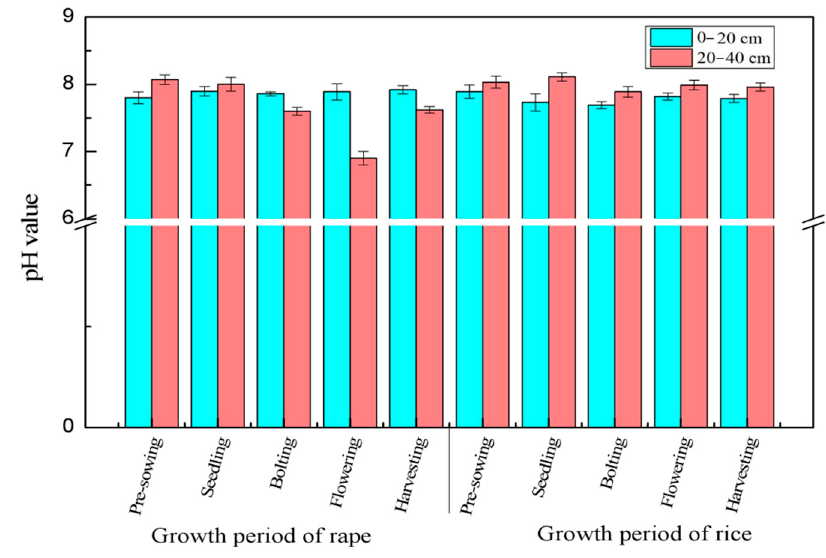
Figure 1. Change of spill pH value during rice–rape